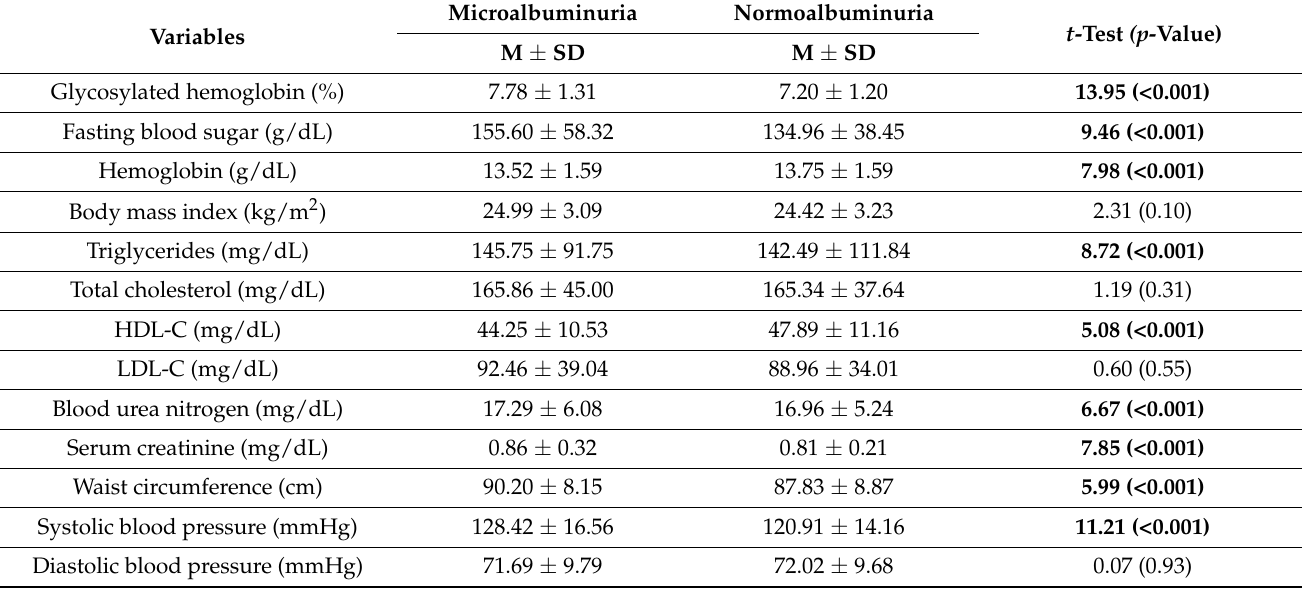
Table 2. Clinical characteristics of the participants according to the microalbuminuria status.